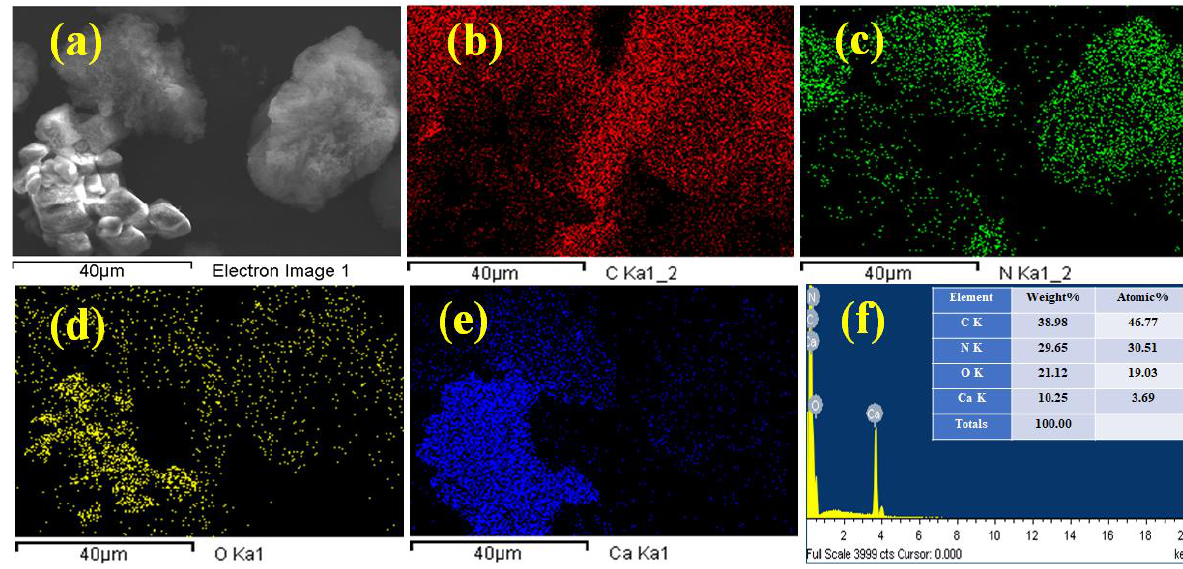
Figure 1. ( a – e ) Elemental mapping distribution and ( f ) EDX graph of CaO-g-C 3 N 4 nanosorbent.